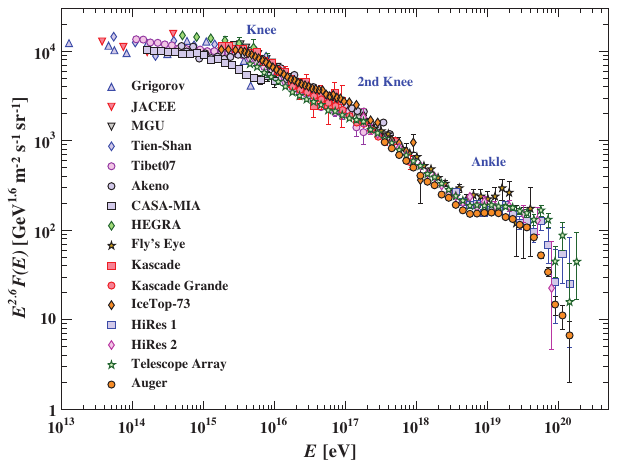
Figure 1. Charged cosmic ray spectrum measured from 10 13 eV to few 10 20 eV by cosmic ray observatories. The spectrum features corresponding to in fl ections points around 10 16 eV, 10 17 eV, and 10 19 eV are highlighted with the “ knee ” , “ 2nd knee ” , and the “ ankle ” . UHECRs are in the range of energies above 10 18 eV. Taken from [44], see also [45] and references